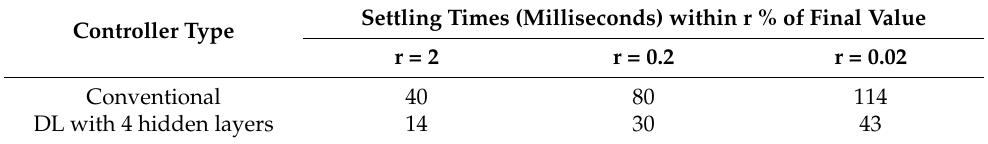
Table 2. Unit step response settling times for different controllers under plant gain change.